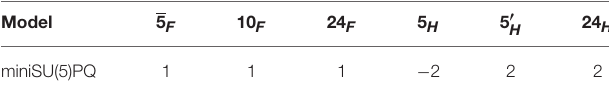
TABLE 5 | Field content and PQ charge assignments in two distinct SO (10) U (1) PQ models (Ernst et al., ×